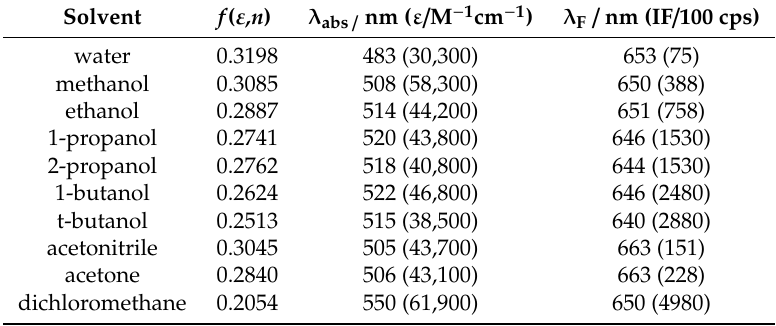
Figure 3. Photograph of 2 × 10 − 5 M solutions of PhSt in (from left to right) water, methanol, ethanol, n -propanol, i -propanol, n -butanol, t -butanol, acetonitrile, acetone, and dichloromethane. Table 1. Absorption and fluorescence spectral data of PhSt in di ff erent